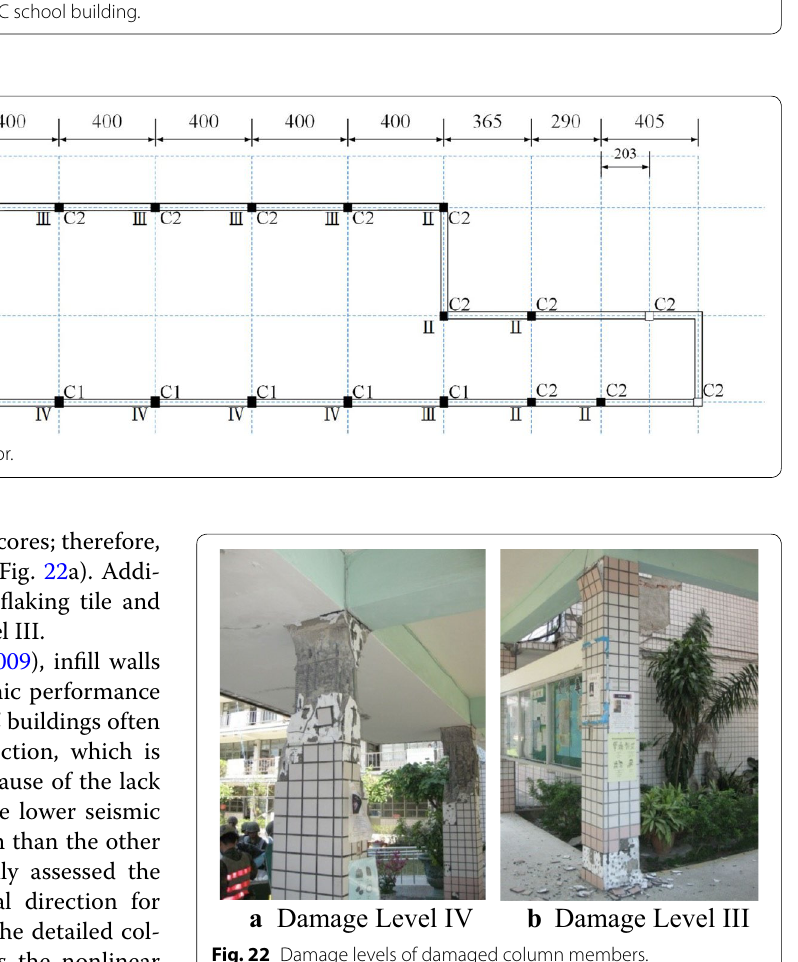
Fig. 22 Damage levels of damaged column